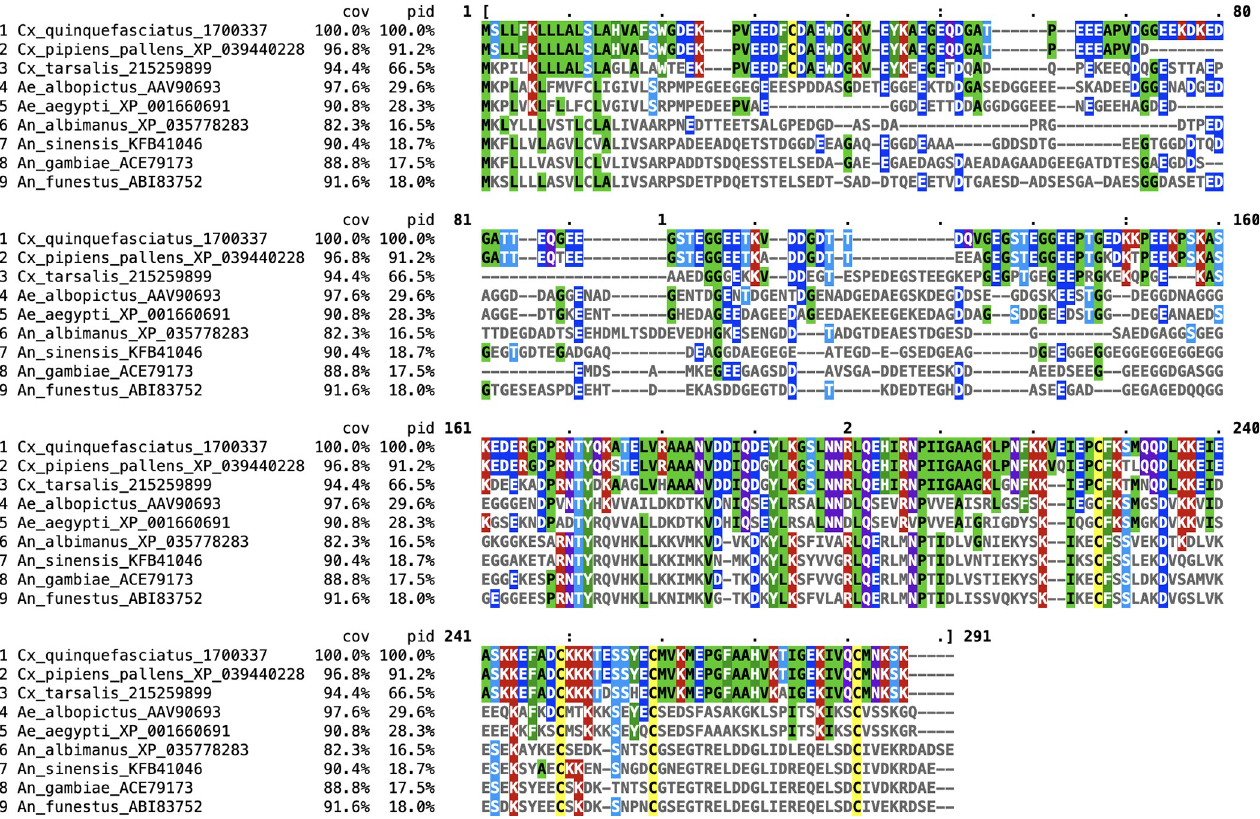
Fig 2. Alignment of arthropod protein orthologs of the 30 kDa protein from Cx . quinquefasciatus . Species, accession numbers, percentage of protein coverage (cov), percentage of identical amino acid residues (pid) and amino acid positions are indicated. Residues identical to the reference sequence of Culex quinquefasciatus are highlighted in different colors according to the amino acid properties. For each species the protein homolog producing the best score was selected for the alignment.